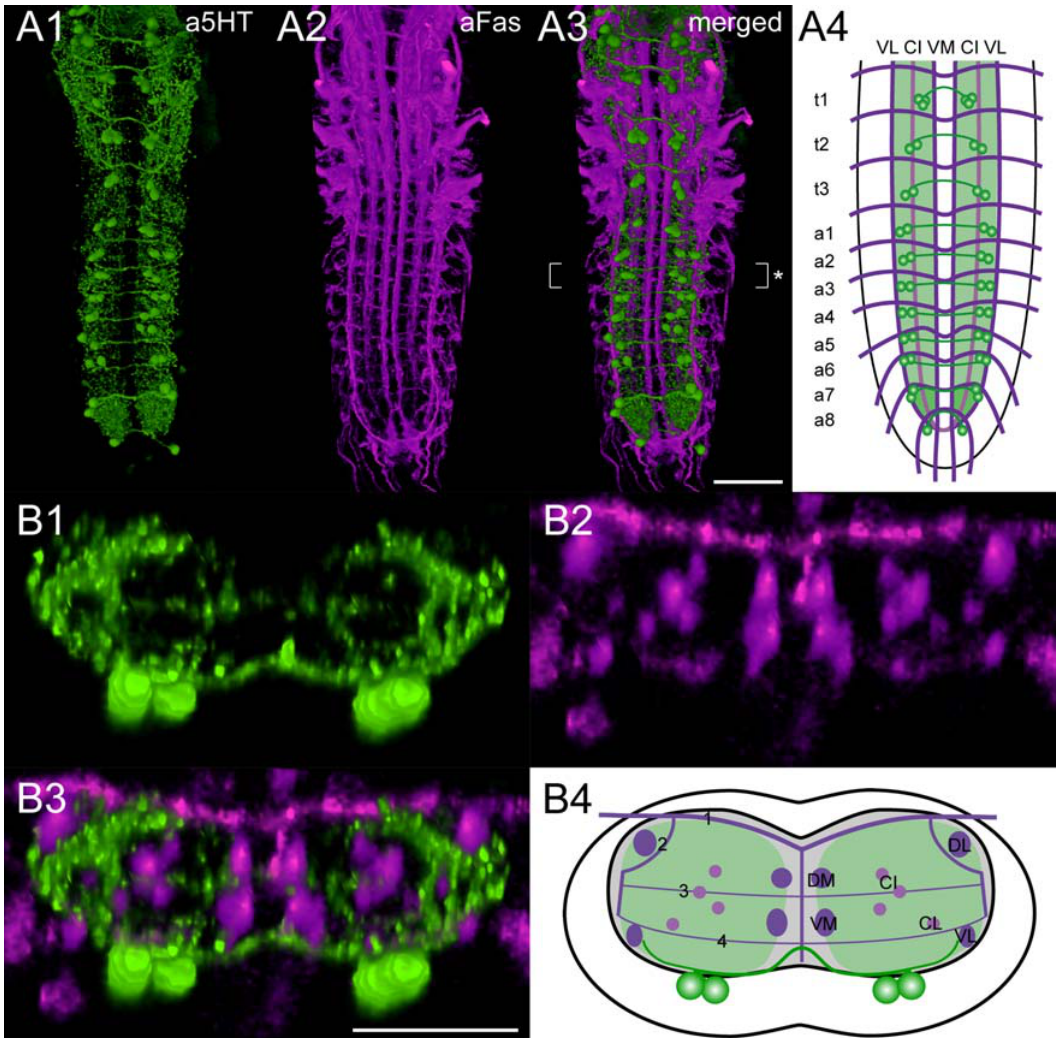
Figure 3. Mapping of 5-HT-immunoreactive neurons. Ventral view of 3D image stacks showing volume-rendered A1) 5-HT-immunoreactive neurons (green) and A2) Fas2-positive tracts (magenta) in a larval VG. The merged image (A3) served for an idealized schematic representation of presumed 5-HT neurons in the Fas2 landmark system (A4). B1-3) Corresponding transversal views of the neuromere a2 (* in A3), and B4) the deduced idealized transversal scheme. Green-shaded areas in the schemes contain a high concentration of 5-HT-immunoreactive arborizations. Scale bars: 50 m m in A), 25 m m in B).